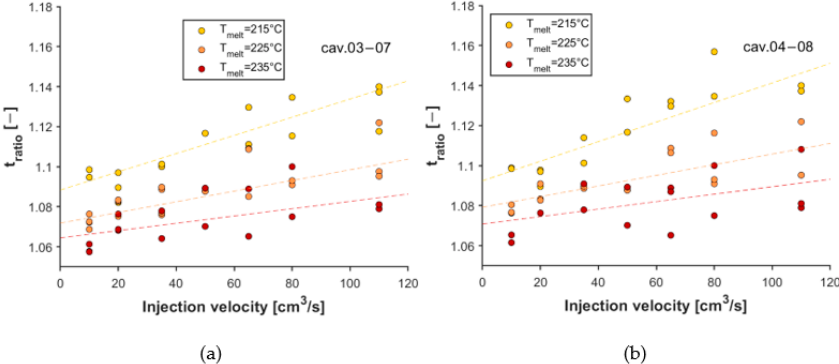
Figure 10. Effect of melt temperature and injection rate on the ratio of the longest and shortest melt arrival times: ( a ) cavity 03–07; ( b ) cavity 04–08. arrival times: ( a ) cavity 03–07; ( b ) cavity